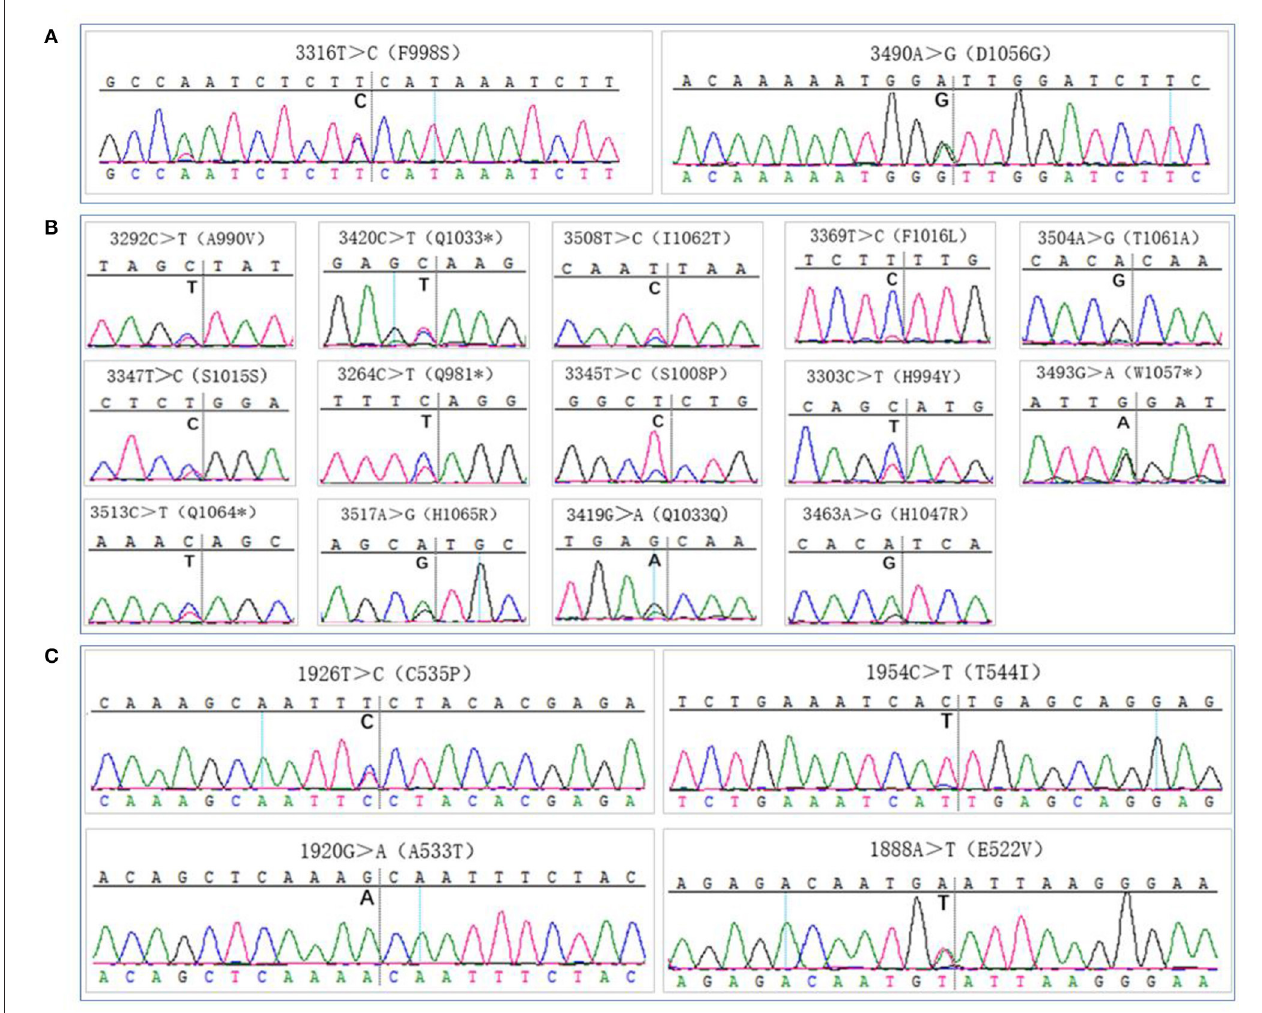
FIGURE 5 | Gene mutation analysis. (A) PIK3CA gene mutation sites detection by routine sampling (focused on the exon 20), (B,C) PIK3CA gene mutation sites detection by multi-site tumour sampling [dispersed in exon 20 (B) and exon 9 (C)